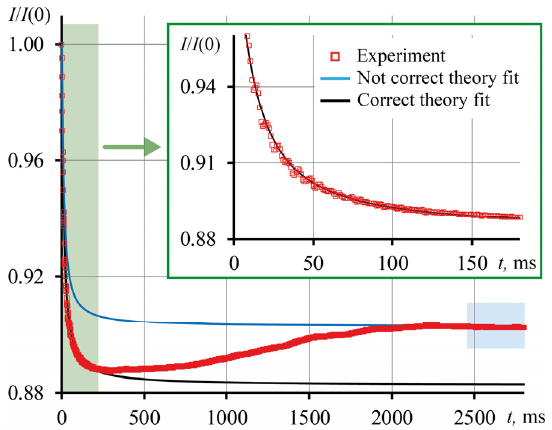
Figure 8. Transient curve for a HS sample ( d av = 12 nm, with a concentration of 22.4 mg/mL): red dots, experiment; the blue line is the theoretical transient curve constructed using the averaging of the last 300 points of the experimental transient curve as a steady state; the black line is the theoretical transient curve built by fitting the first 100 ms of the experiment.